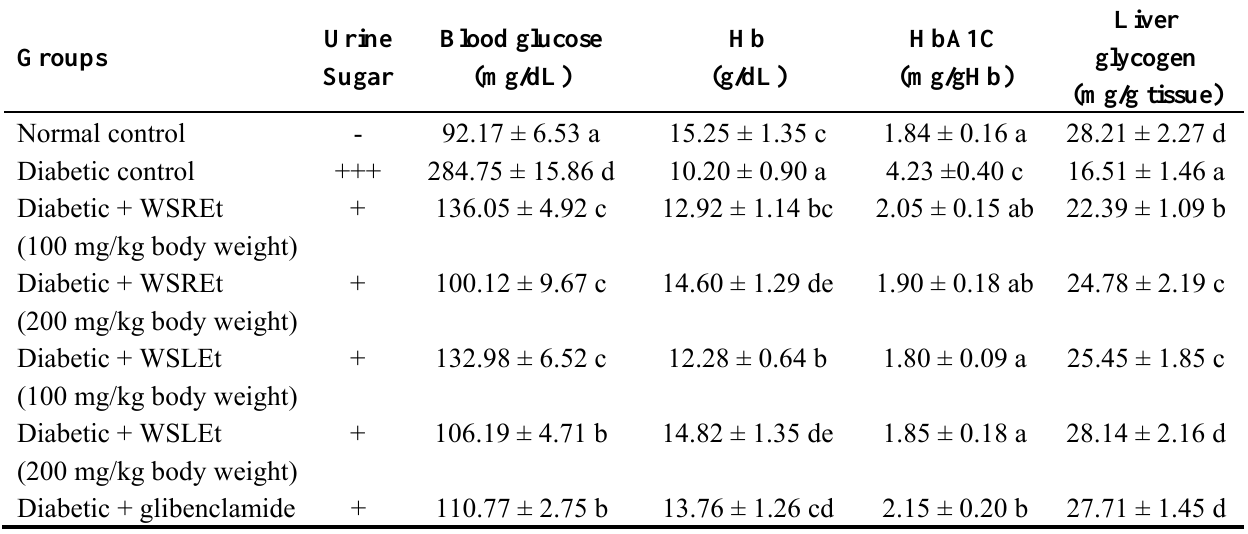
Table 3. Effects of W. somnifera (L.) extracts on urine sugar, blood glucose, haemoglobin, glycosylated haemoglobin and liver